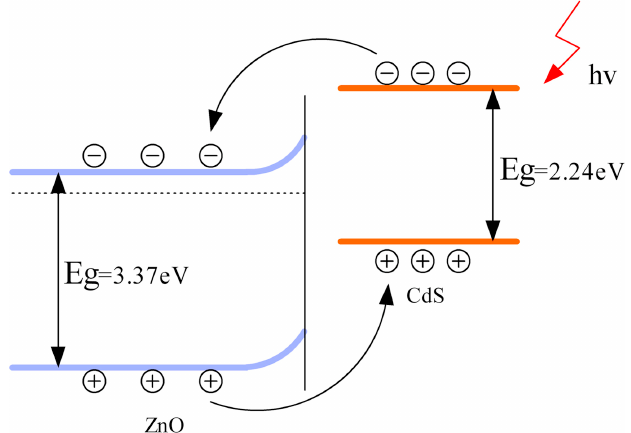
Figure 49. Dynamic sensing plots of Cds-ZnO to 1 ppm NO 2 at room temperature vs. ( a ) green light intensity (0, 0.05 and 0.15 W/cm 2 ); ( b ) different light wavelength. Reproduced with permission from [73].